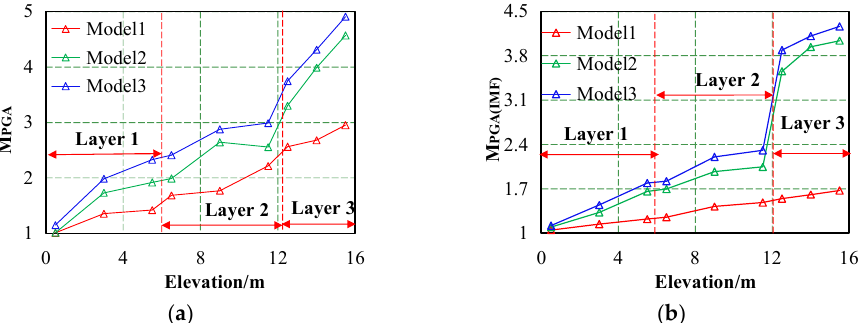
Figure 12. Change of the PGA amplification coefficient of the models when inputting the WE wave in the x direction: ( a ) M PGA and ( b ) M PGA(IMF) .